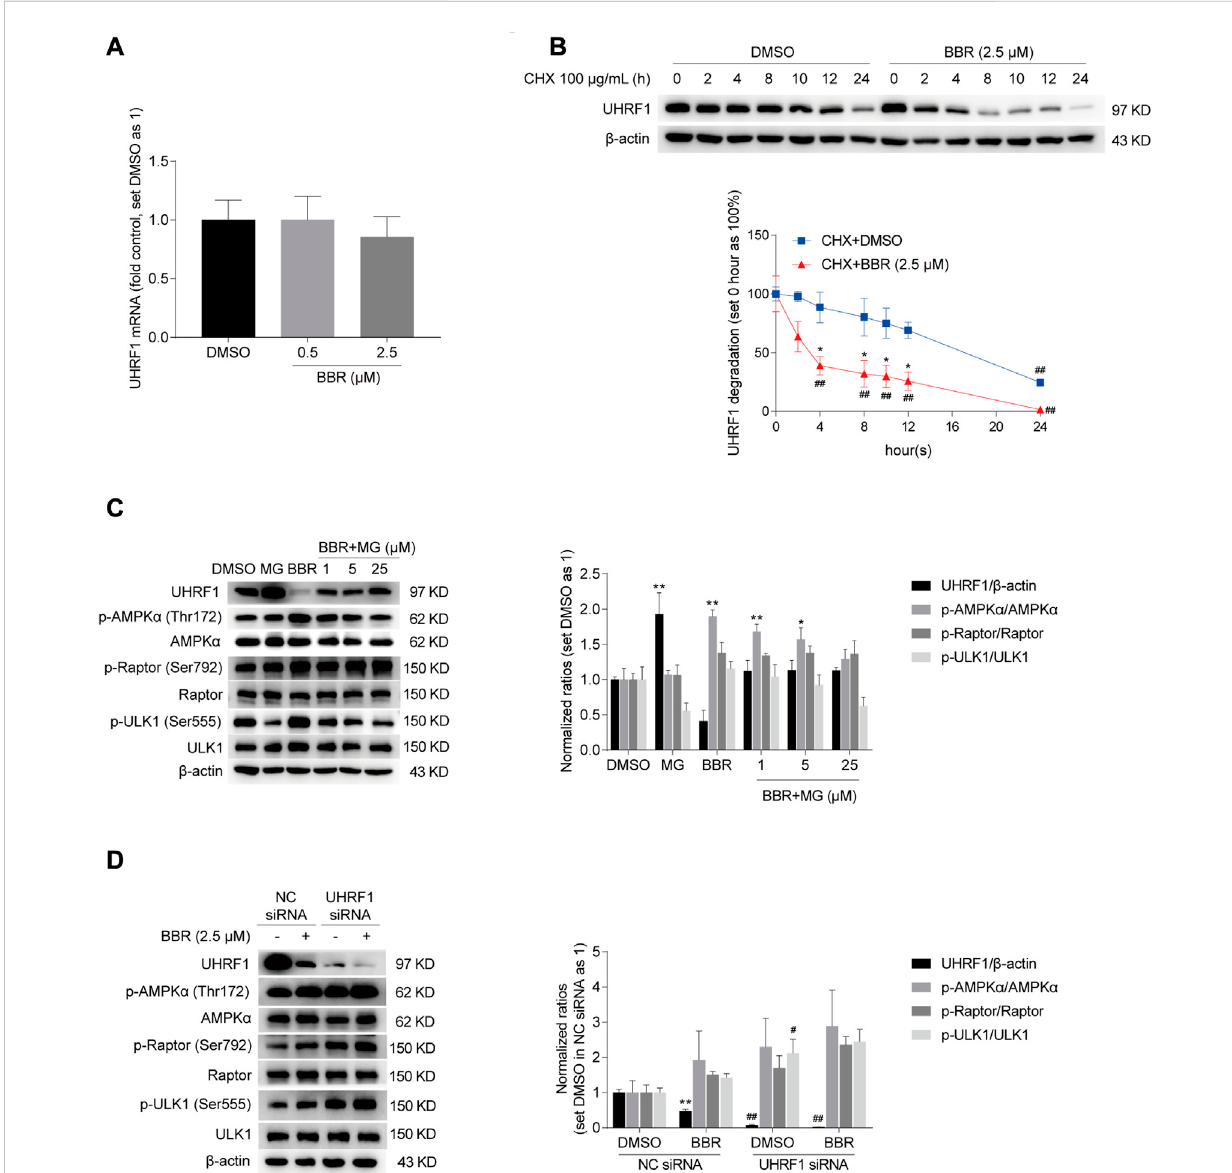
BBR downregulated UHRF1 by promoting its degradation. BBR hardly decreased the mRNA expression of UHRF1 (A) . HCT-116 cells were treated with BBR (0.5 and 2.5 μ M) and DMSO for 20 h, respectively. UHRF1 degradation was accelerated by BBR treatment (B) . HCT-116 cells were treated with 100 μ g/mL CHX, combined with DMSO and BBR (2.5 μ M) for 0, 2, 4, 8, 10, 12 and 24 h, respectively. The ratio of 0 h was set as 100% in DMSO and BBR treated groups, respectively. MG-132 abolished BBR ’ s effect on UHRF1 downregulation and AMPK activation (C) . HCT-116 cells were treated with DMSO or BBR (2.5 μ M) alone for 24 h, or pretreatment with DMSO or BBR (2.5 μ M) for 20 h and combined with MG-132 (MG, 25 μ M; BBR + MG, 1 μ M, 5 μ Mand 25 μ M)for an additional 4 h.The ratioofDMSO-treated group wassetas 1.BBRfurther reduced UHRF1expression inUHRF1siRNAtransfected cells (D) . HCT-116 cells were transfected independently with UHRF1 and NC siRNAs. 48 h post-transfection, cells were treated with DMSO and BBR (2.5 μ M) for 20 h, respectively. The ratio was set as 1 in the DMSO group of NC siRNA transfected cells. Values are presented as the mean ± SEM of three independent experiments; * p < 0.05, ** p < 0.01 versus that of the corresponding DMSO or CHX + DMSO treated group; # p < 0.05, ## p < 0.01 versus that of the corresponding “ 0 h ” group treated with DMSO and BBR, respectively (B) , or that of the corresponding treated group in the NC siRNA transfected cells (D)